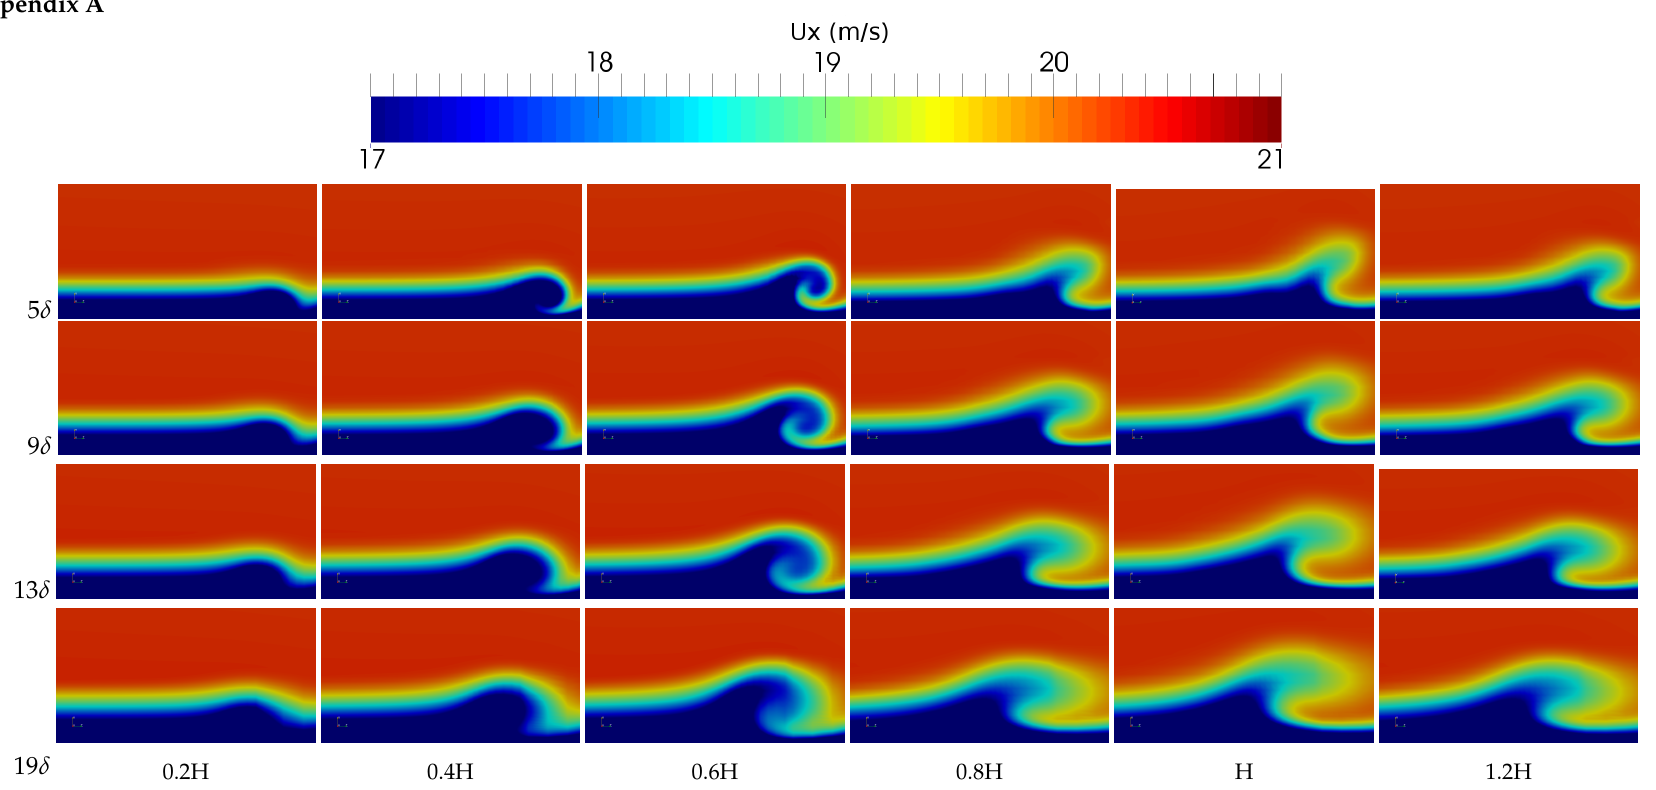
Figure A1. Axial velocity distributions Ux ms − 1 at four different planes normal to the streamwise direction and located at distances proportional to the local boundary layer thickness δ from the edge shown for six vortex generator heights (0.2H, 0.4H, 0.6H, 0.8H, H and 1.2H). Incident angle of β = 10 ◦